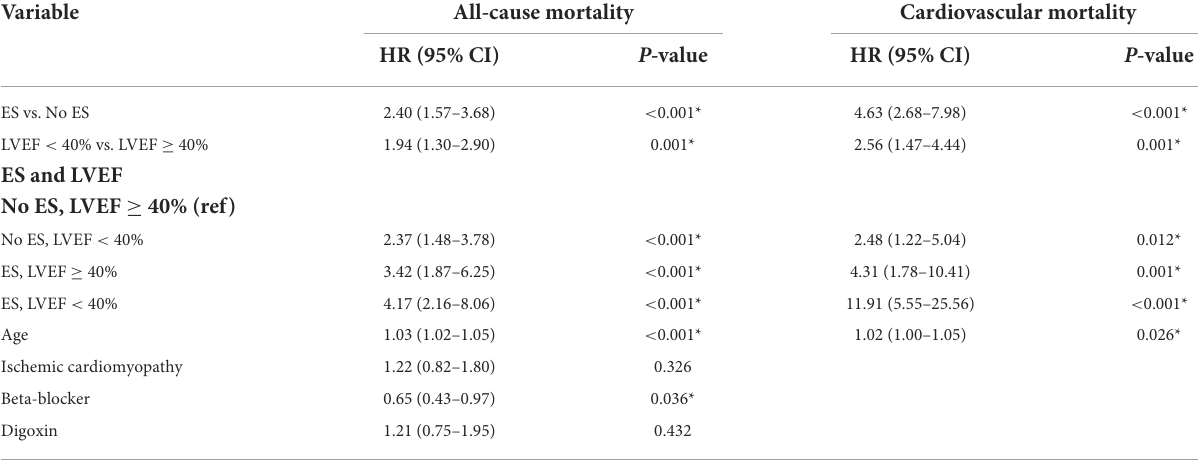
TABLE 4 Multivariable cox regression analysis hazard ratios of all-cause and cardiovascular mortality for the whole population.